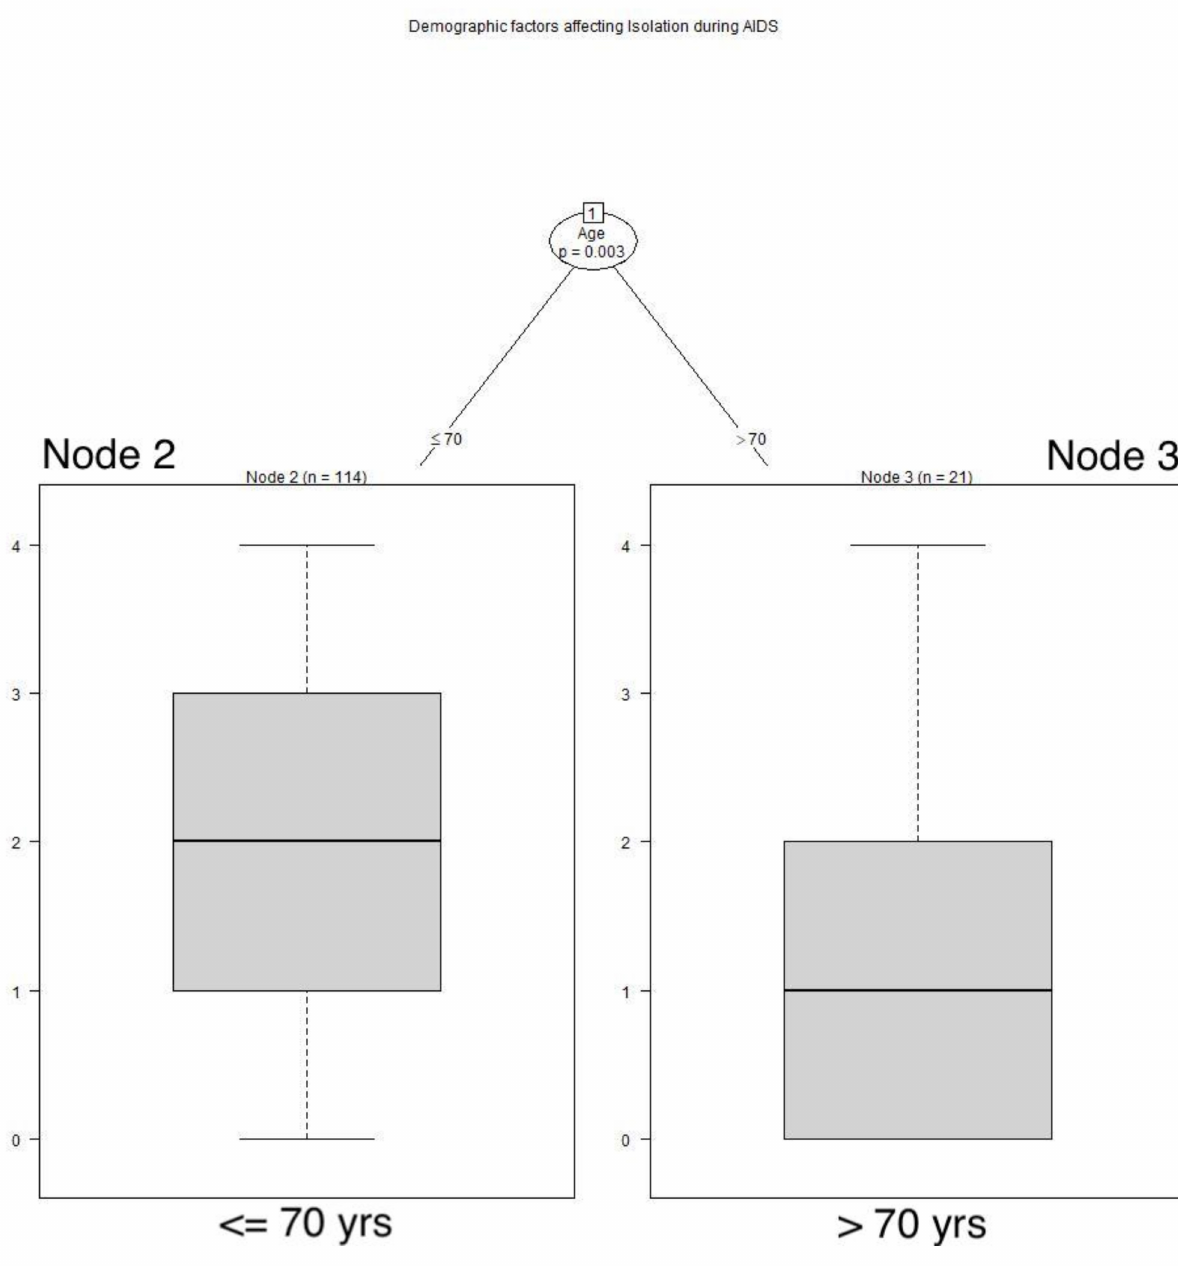
Figure 4. Demographic factors affecting isolation during AIDS. Respondents older than 70 years of age felt isolated less often during AIDS than those who were younger: Node 2: x − = 1.912, SD 1.1641; Node 3: x − = 1.048, SD